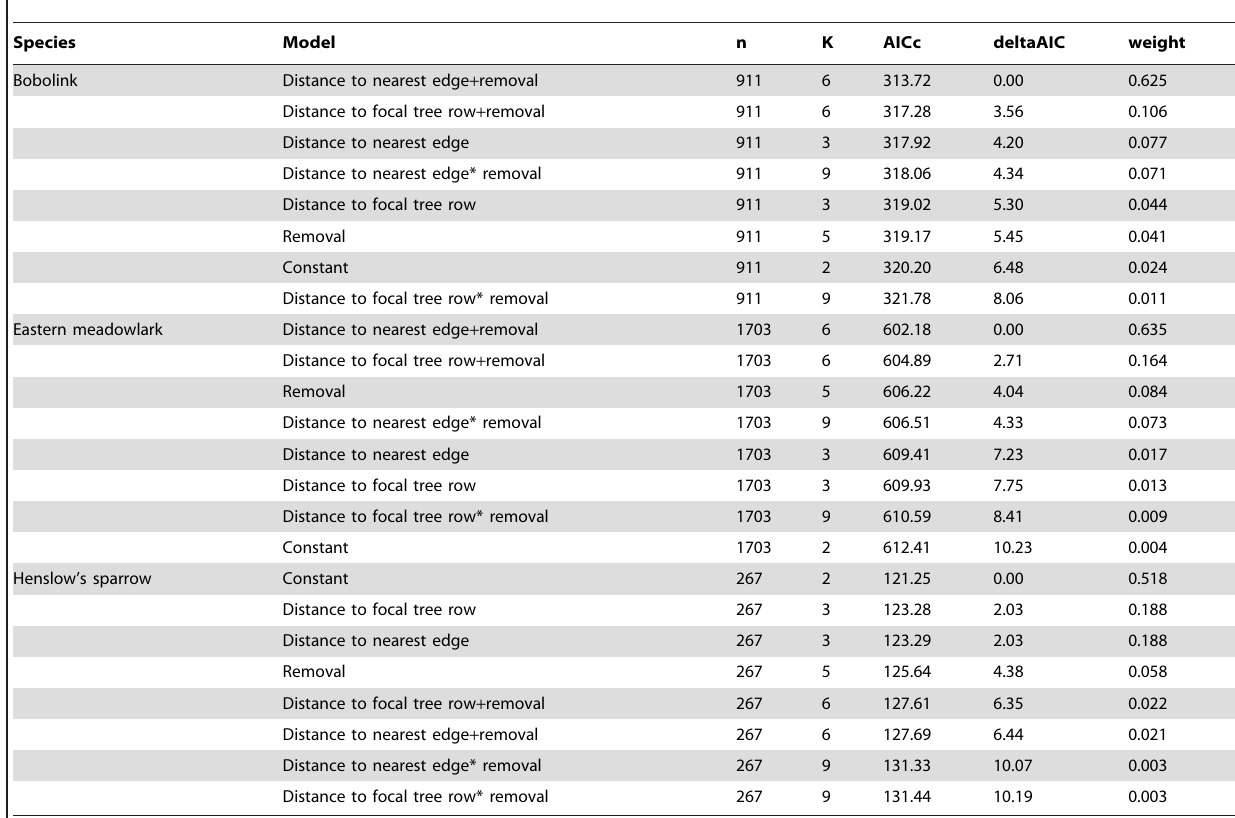
Table 4. AIC results for nest success on control and tree row removal sites.